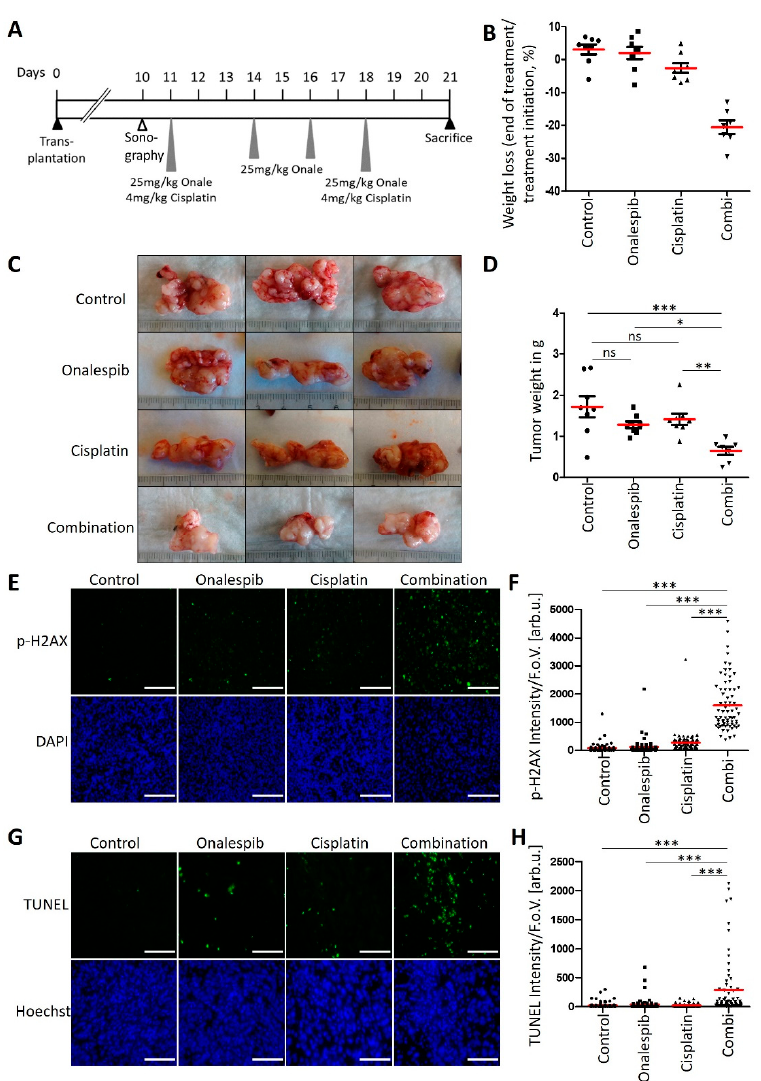
Figure 6. Anti-tumor efficiency of onalespib with cisplatin in a syngeneic mouse model of PDAC. ( A ) Treatment scheme for C57BL/6J mice which were orthotopically transplanted with 200,000 KPC cells. Ten days after transplantation, tumor formation was confirmed by sonography. The treatment with 25 mg/kg onalespib and 4 mg/kg cisplatin was started on day 11 and repeated on day 18. On day 14 and 16, the mice received single treatments with 25 mg/kg onalespib. 21 days after transplan- tation, the mice were sacrificed for removal of the tumors. ( B ) Weight loss of animals in response to treatment. ( C ) Images of three representative pancreatic tumors collected from mice treated accord- ing to ( A ) at the endpoint of the experiment (day 21). ( D ) Tumor weight was determined after nec- ropsy on day 21. Red lines indicate the mean weight. Control, onalespib, and cisplatin single treat- ment groups ( n = 8), and the combination treatment group ( n = 7). ( E , G ) Tumor sections from ( C ) were stained for ( E ) phospho-H2Ax and ( G ) apoptosis using a TUNEL assay and subjected to fluo- rescence microscopy. Scale bar, 200 µm. ( F , H ) Calculated intensity of ( F ) phospho-H2AX and ( H ) TUNEL staining per field of view, depicted as scatter blot. Ten images per mouse were randomly